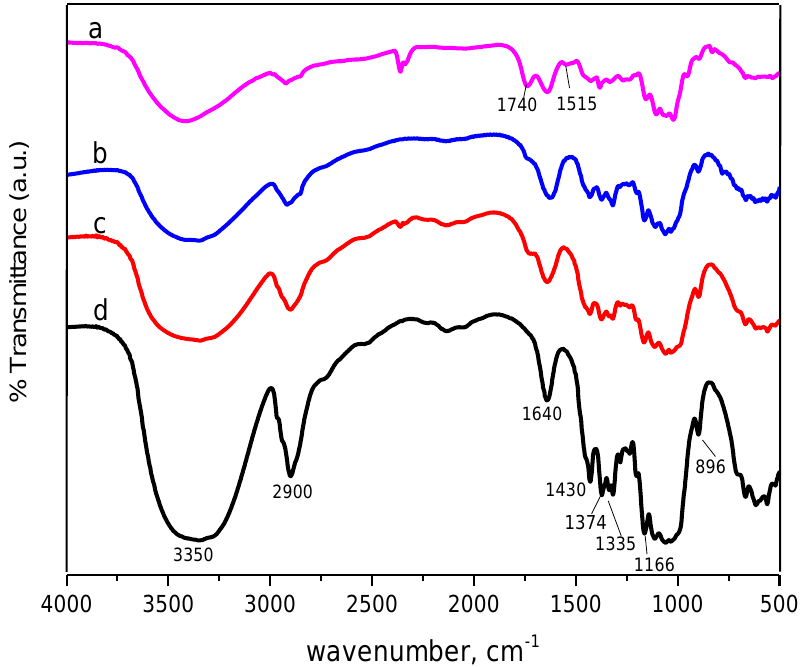
Figure 2. FTIR spectra of ( a ) raw CPs, ( b ) CNF procedure I, ( c ) CNF procedure II, and ( d ) microcrystalline cellulose (MCC). Table 2. Assignment of characteristic absorption peak (cm –1 ) in cellulosic material [18].